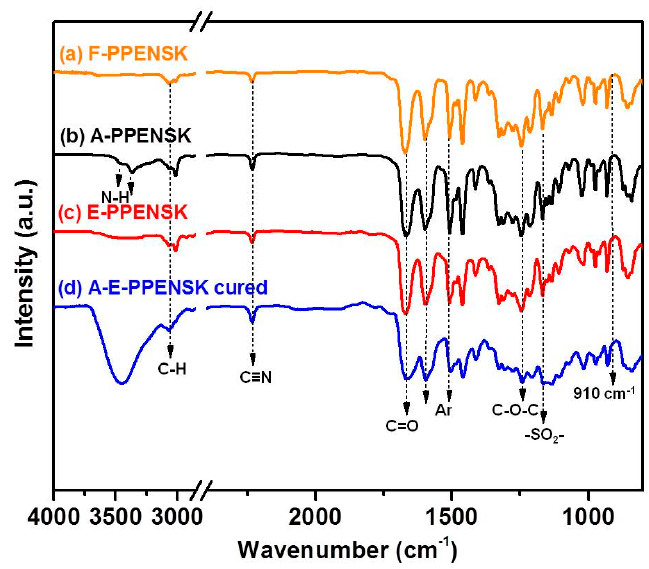
Figure 1. Fourier transform–infrared (FT–IR) spectra of various polymers.